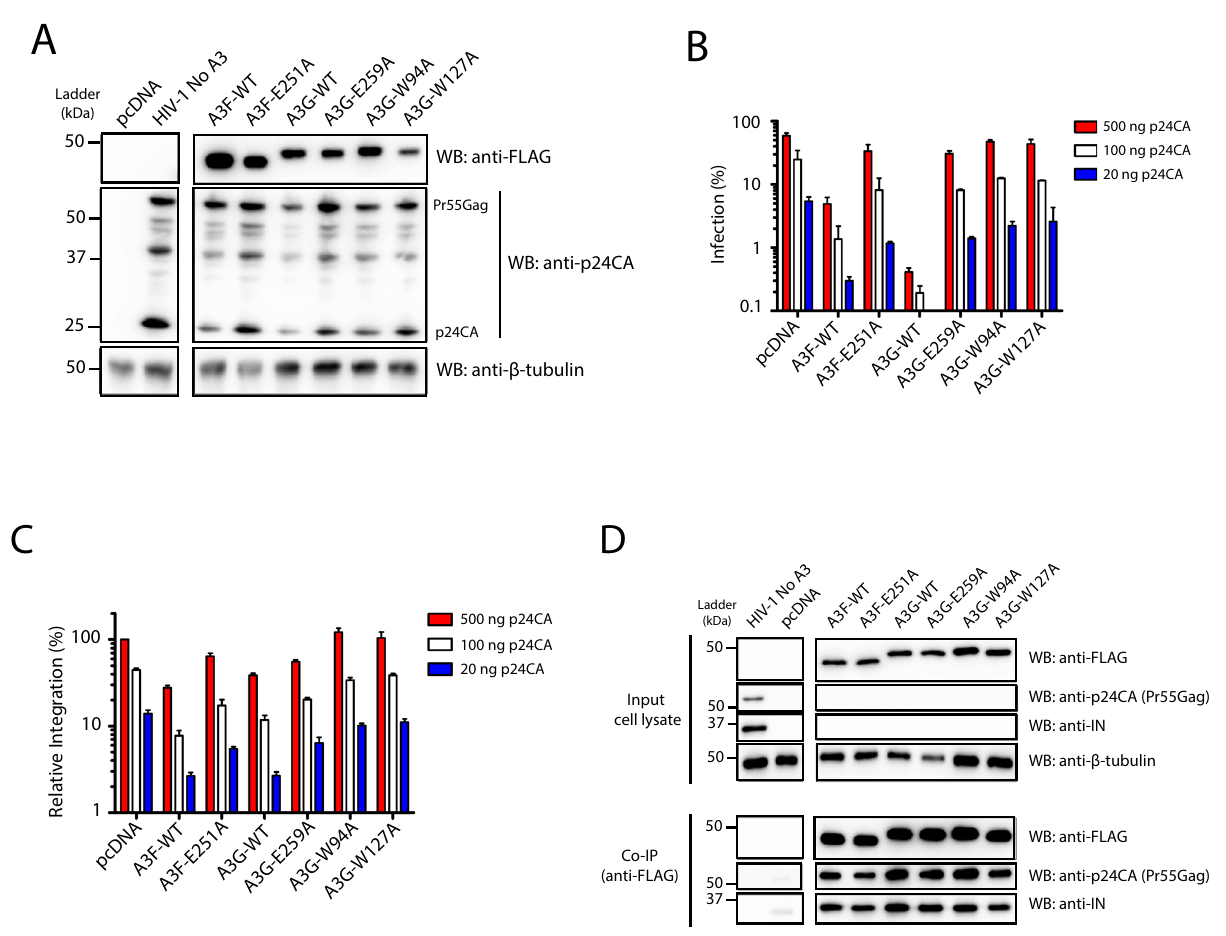
Fig. 1 | A3-mediated restriction of HIV-1 integration. A Western blot analysis of virus producer cells. HIV-1 pseudotyped virus was produced in 293T cells by co- transfection of plasmids coding for NL4-3- Δ Env/ Δ Vif/eGFP, VSV-G, and either empty pcDNA 3 plasmid (HIV-1 no A3), or each of the A3 expression plasmids. The Control lane is the transfection of the pcDNA in absence of virus. Cell lysates were subjected to SDS-PAGE and Western blot analysis. B CEM-SS cells were infected with the amounts of virus as indicated after normalization to capsid (p24CA) pro- tein, as determined by ELISA. Infection was measured as the percentage of eGFP+